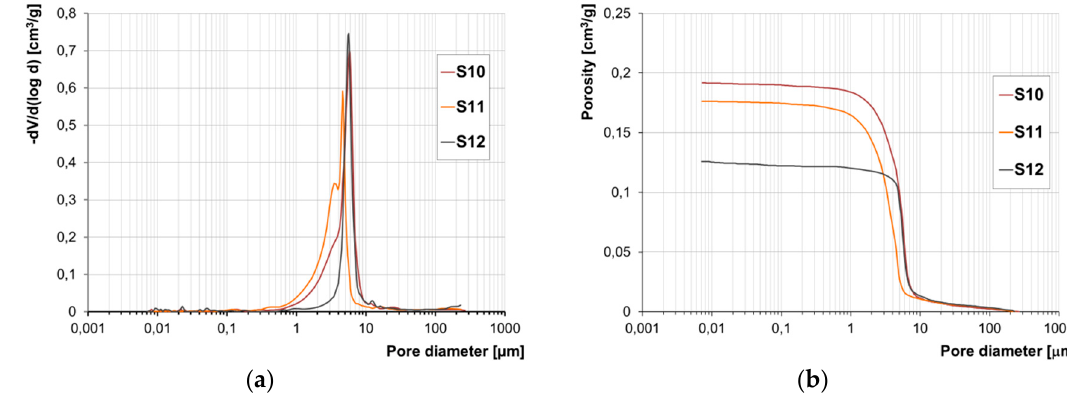
Figure 10. Pore size distribution ( a ) and cumulative curves of pores volume distribution ( b ) for bricks without signs of damage S10, S11 and S 12.